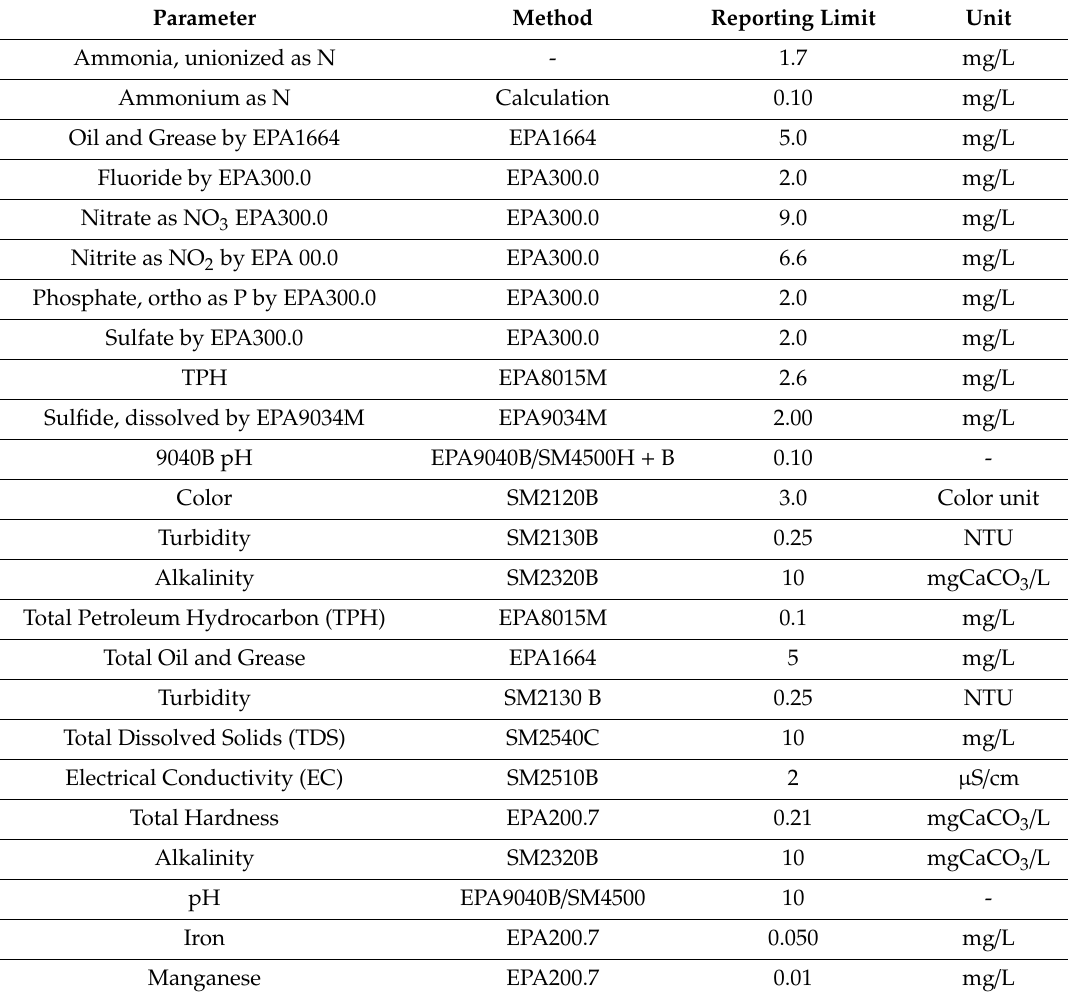
Table A2. List of o ff site analysis, methods and reporting